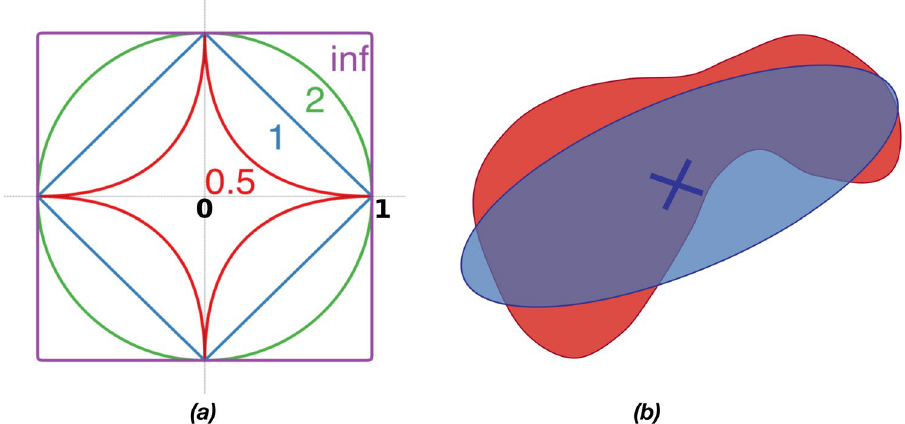
Figure 1. ( a ) Illustrations of some unit L p -balls in two dimensions: p → ∞ : the L ∞ -ball (rectangle), p = 2: the L 2 -ball (circle), p = 1: the L 1 -ball (diamond), and p = 0.5: the L 0.5 -ball (star). ( b ) Samples are randomly drawn from the proposal distribution (blue), which is an affine transformation of an L p -ball. The hitting probability P is the probability that the sample lies inside the feasible region (red). For uniform sampling, P is given by the overlap area between the proposal and the feasible